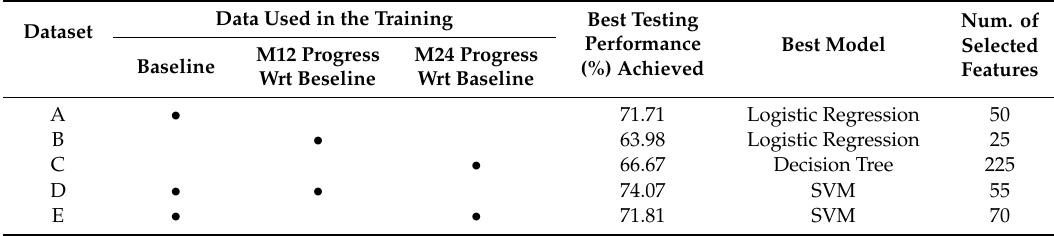
Table 9. Summary of all reported